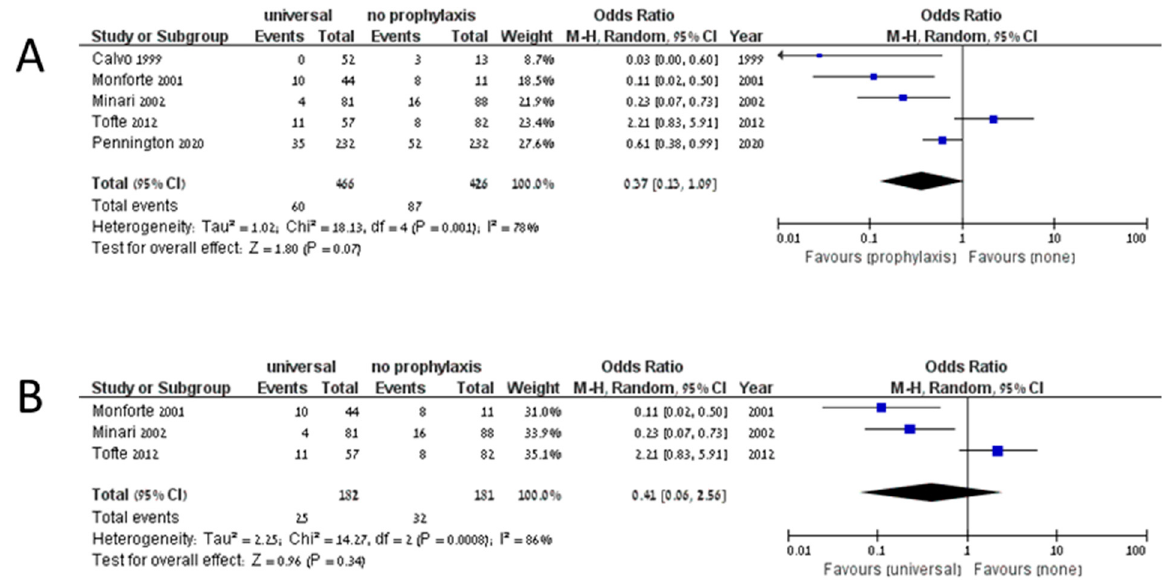
Figure 2. Invasive fungal disease ( A ) and invasive aspergillosis ( B ) in studies comparing universal prophylaxis and no prophylaxis.